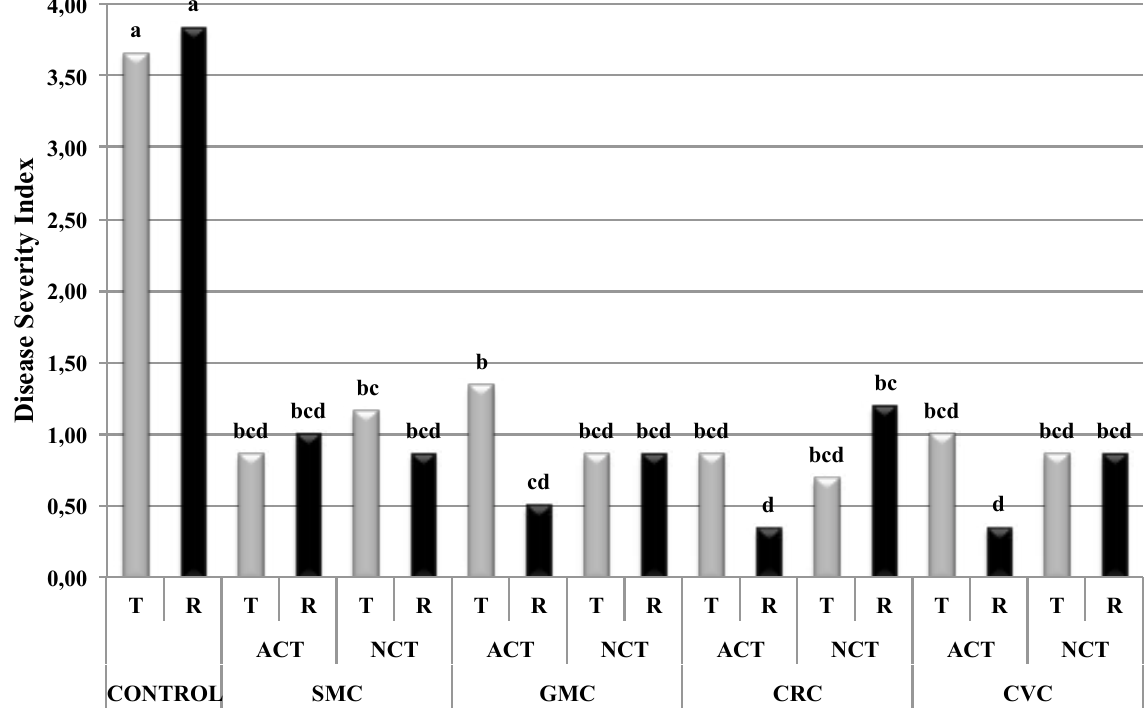
Figure 4. Mean severity of Phytophthora parasitica on retreated (R) and non-retreated (T) plants with aerated compost tea (ACT) and non-aerated compost tea (NCT) from spent mushroom compost (SMC), grape marc compost (GMC), crop residues compost (CRC) and crop residues vermicompost (CRV). Applied compost teas were obtained in ratio 1:4 w:v. Controls were retreated (R) or non-retreated (T) with tap water. Readings was performed 15 days after inoculating. Disease index values (Santos et al., 2008) are 0, healthy plant; 1, symptoms beginning; 2, moderate symptoms; 3, severely affected plant; 4, dead plant. Different letters indicate significant differences according to One-Way ANOVA tests ( P